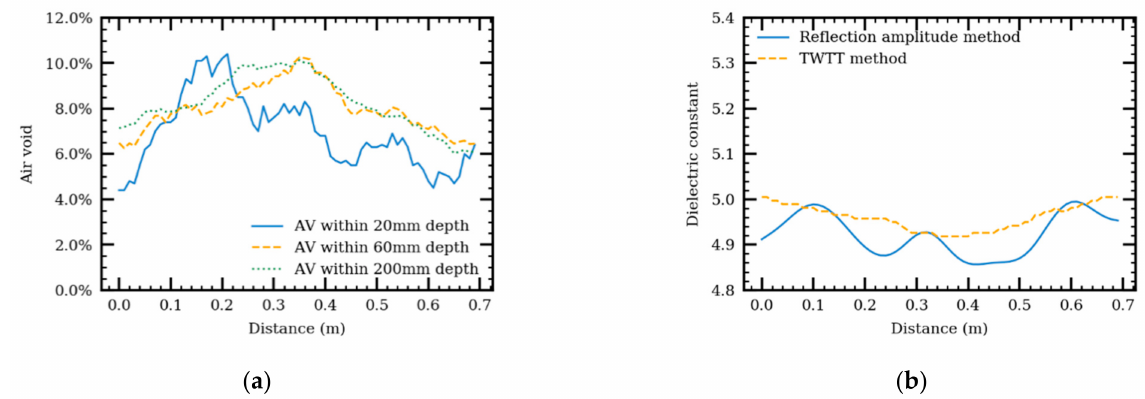
Figure 12. Air void distribution along distance ( a ) and dielectric constant along distance using the reflective amplitude and TWTT methods ( b